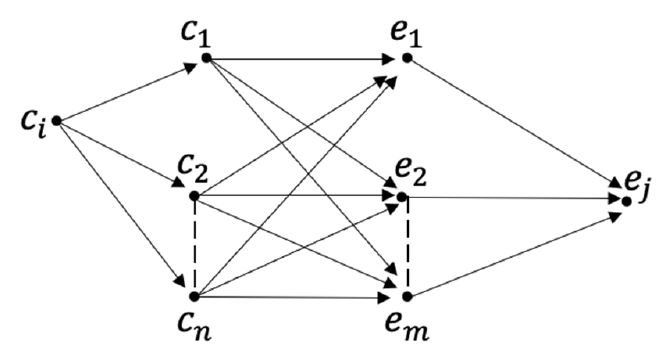
Figure 9. The max-min composition of the matrices.